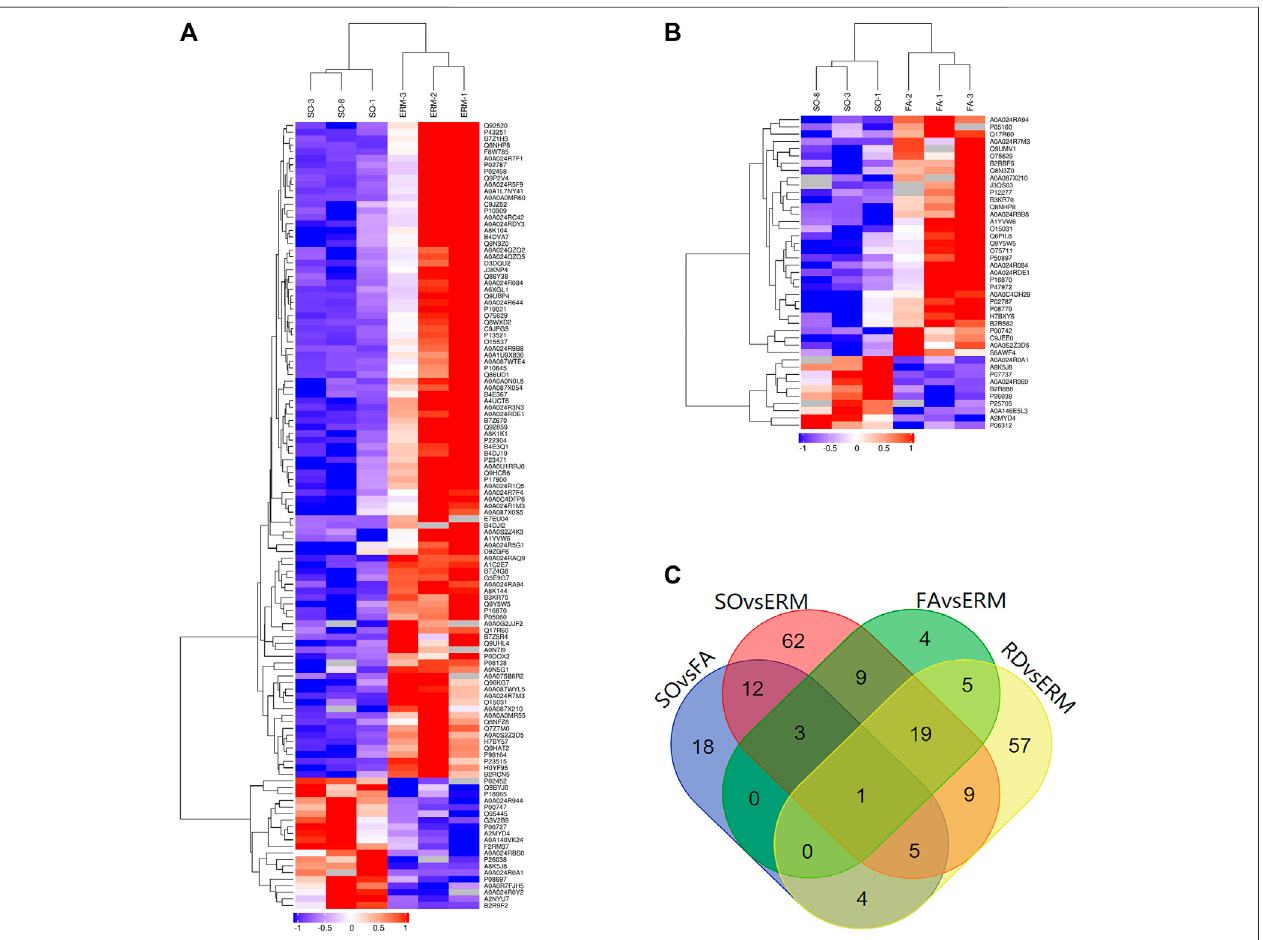
FIGURE 3 | Differential protein clusters. (A) SO vs . ERM. (B) SO vs . FA. (C) The overlapping changes between four groups of RD, ERM, FA, and